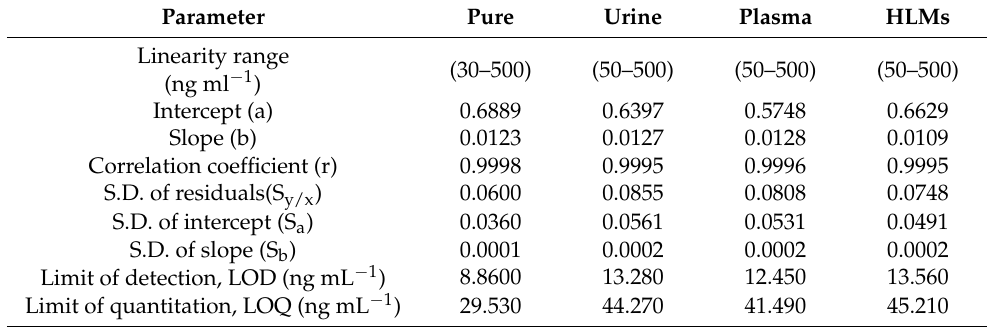
Table 1. Performance data for the estimation of VNB by the proposed analytical methodology.